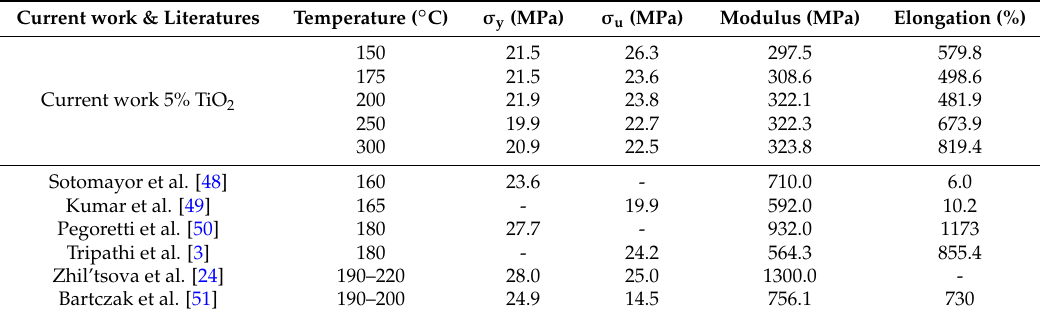
Figure 7. Stress-strain curves of injection molded nanocomposites with varying barrel temperature (BT), nanocomposites BT1–BT5 at 150 °C, 175 °C, 200 °C, 250 °C, and 300 °C, respectively. Table 1. Mechanical properties of injection molded high density polyethylene (HDPE) based nanocomposites from the current literature.